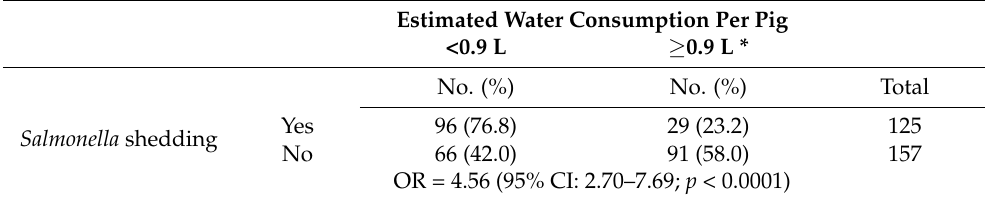
Table 3. Number of pigs shedding Salmonella and estimated water consumption per